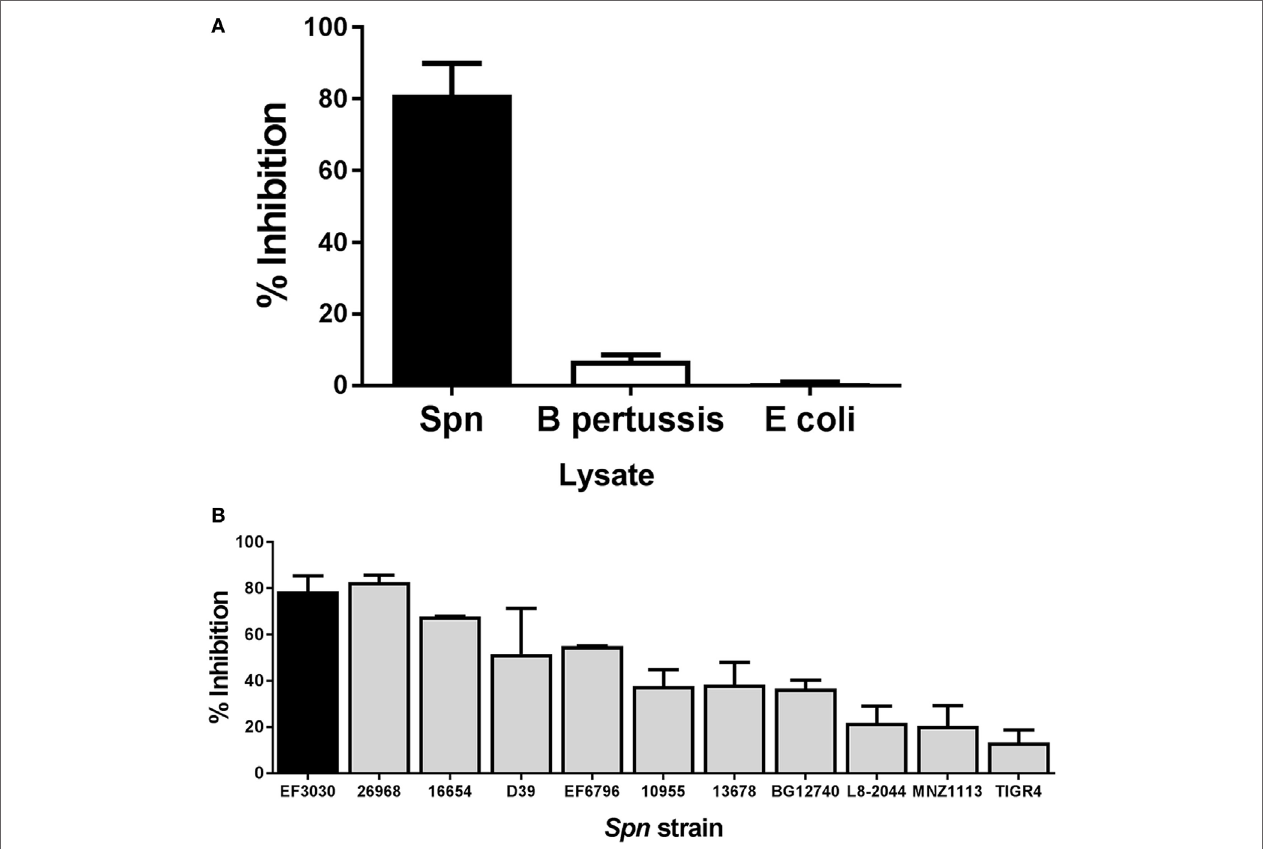
FigUre 3 | Inhibition of cytotoxic T lymphocyte (CTL) function is a property of pneumococcal, but not bacterial lysates in general. NP-specific CTL were stimulated in vitro in the presence of lysates derived from other bacterial species or a panel of Spn strains. Averaged data ± SEM from three to six independent experiments (a) or two to eight independent experiments (b) are shown. Percent inhibition reflects loss of IFN γ production. Experiments were conducted using a minimum of two independently derived CTL